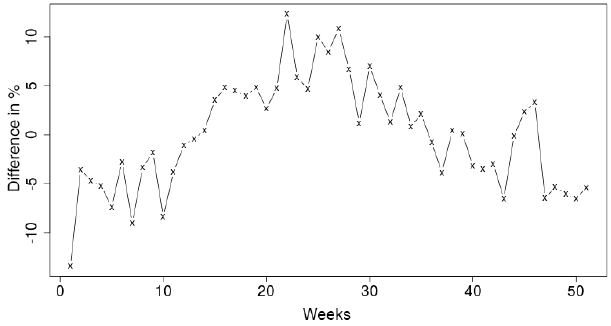
Figure 2. Monthly deviation from the annual mean fuel consump- tion in the North Sea in